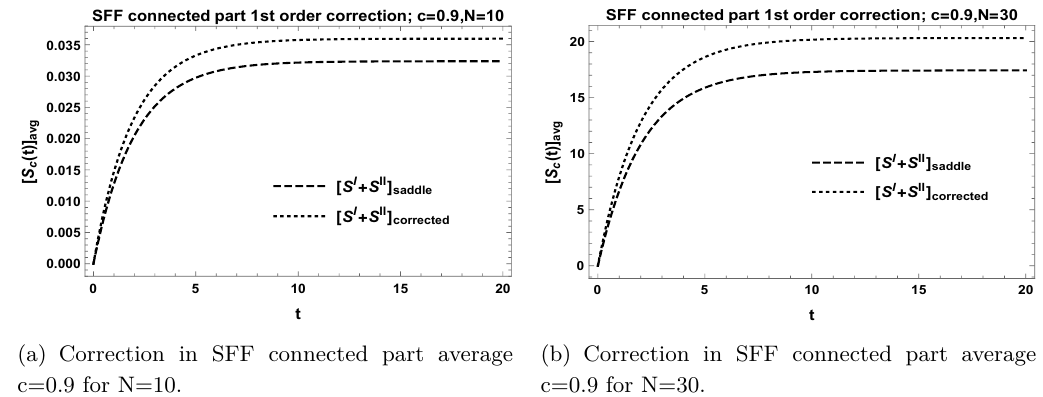
Figure 7 . 1st order correction of Spectral Form Factor w.r.t. τ for N =20 behave in the same way as the zeroth order solution.